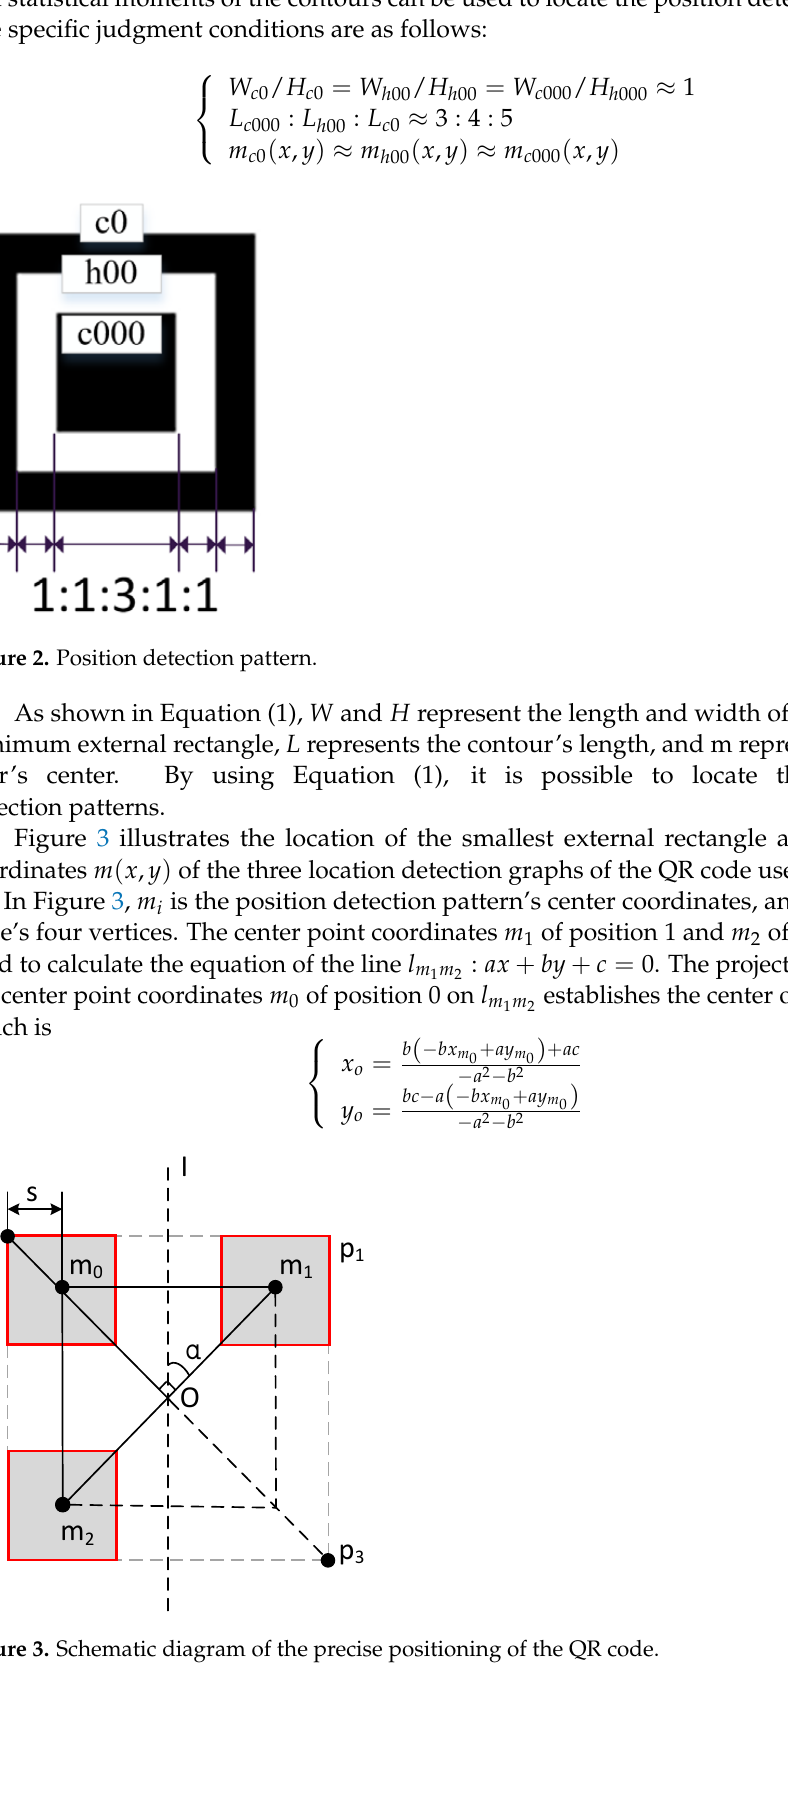
Figure 3. Schematic diagram of the precise positioning of the QR code.